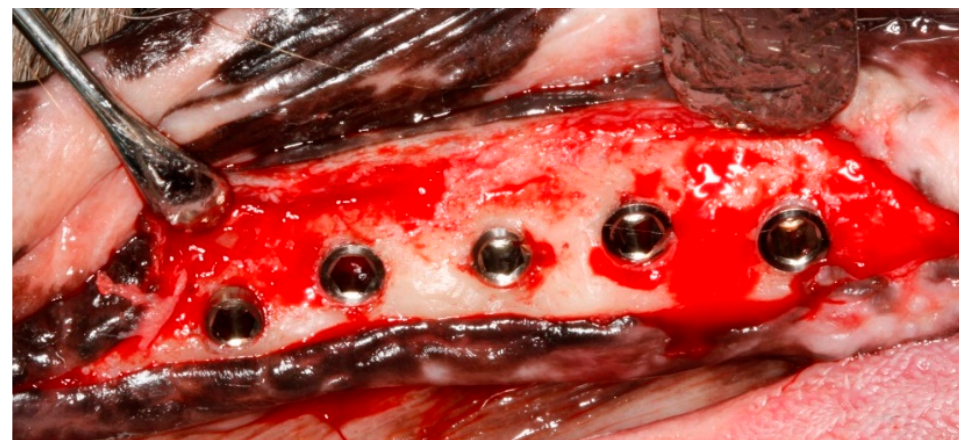
Figure 1. Timeline of the experiment.